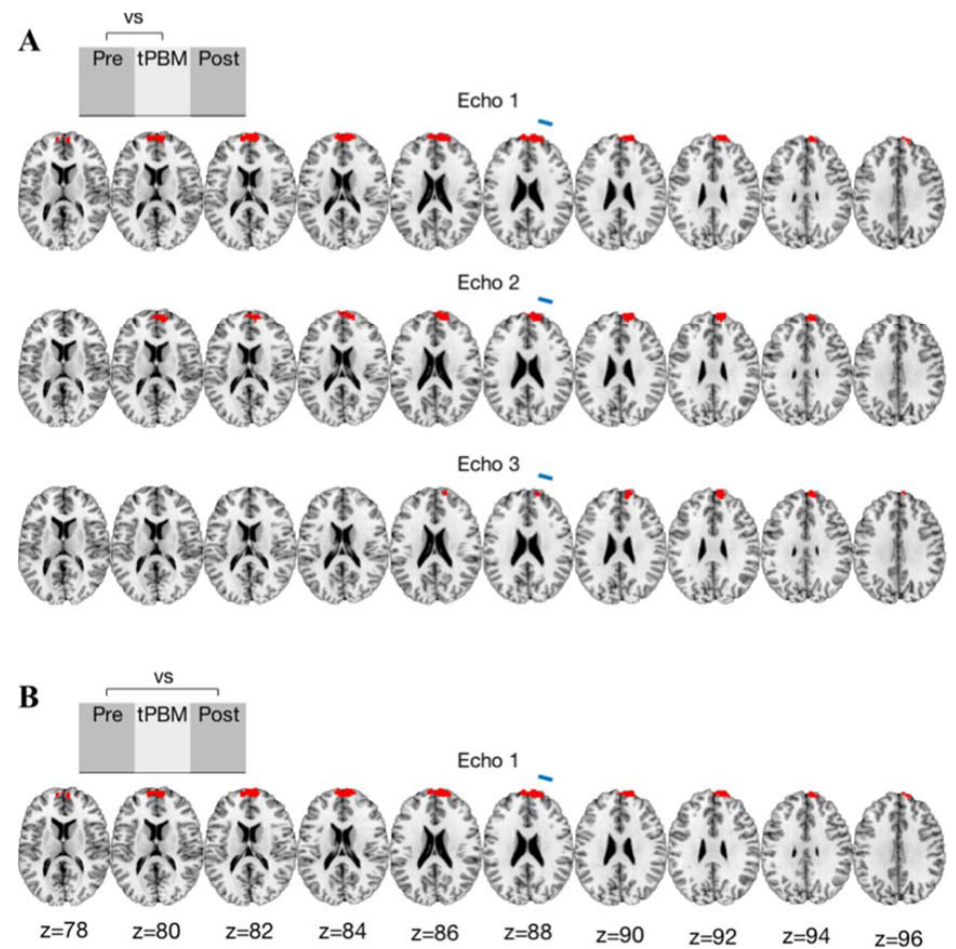
Figure 3 . tPBM modulates fMRI ‐ BOLD during and after stimulation. (A) An acute modulation of Figure 3. tPBM modulates fMRI-BOLD during and after stimulation. ( A ) An acute modulation of BOLD at prefrontal regions was observed at all 3 echos. (B) A lasting effect post tPBM was detected BOLD at prefrontal regions was observed at all 3 echos. ( B ) A lasting effect post tPBM was detected in echo 1. “Z” represents the axial slice position. in echo 1. “Z” represents the axial slice